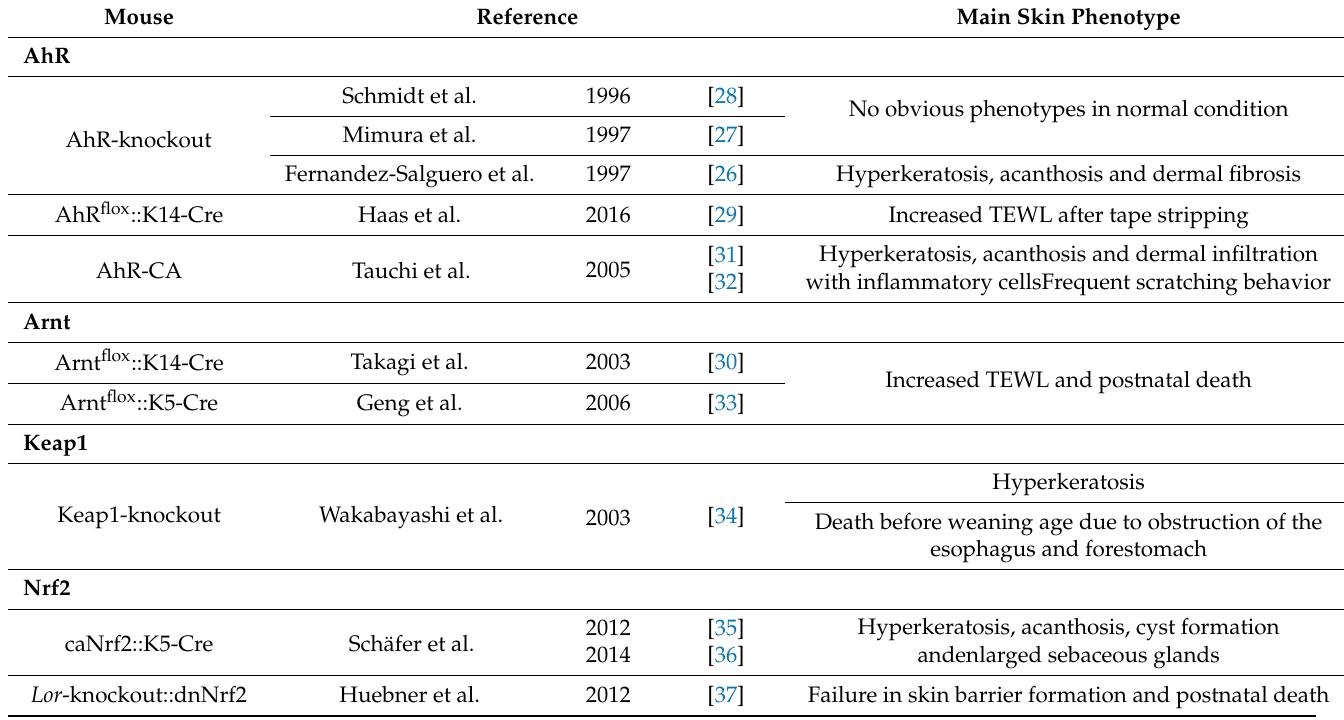
Table 1. Genetically modified mouse models targeting AhR/Arnt and